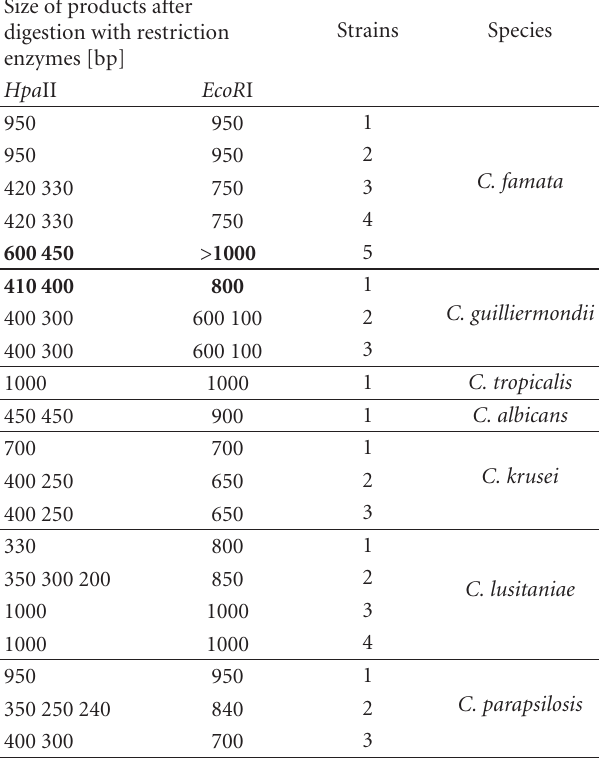
Table 3: Restriction endonuclease analysis of PCR products digested with Hpa II and EcoR I. Black bold type fonts shows Warsaw